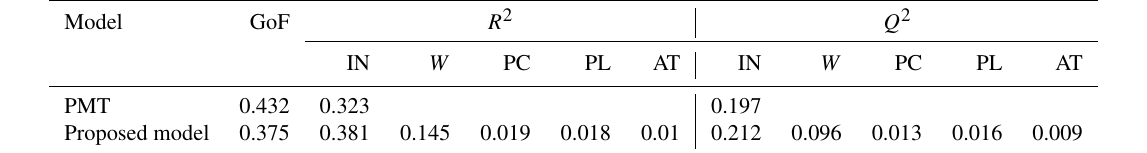
Table 4. Results of GoF, R 2 and Q 2 .